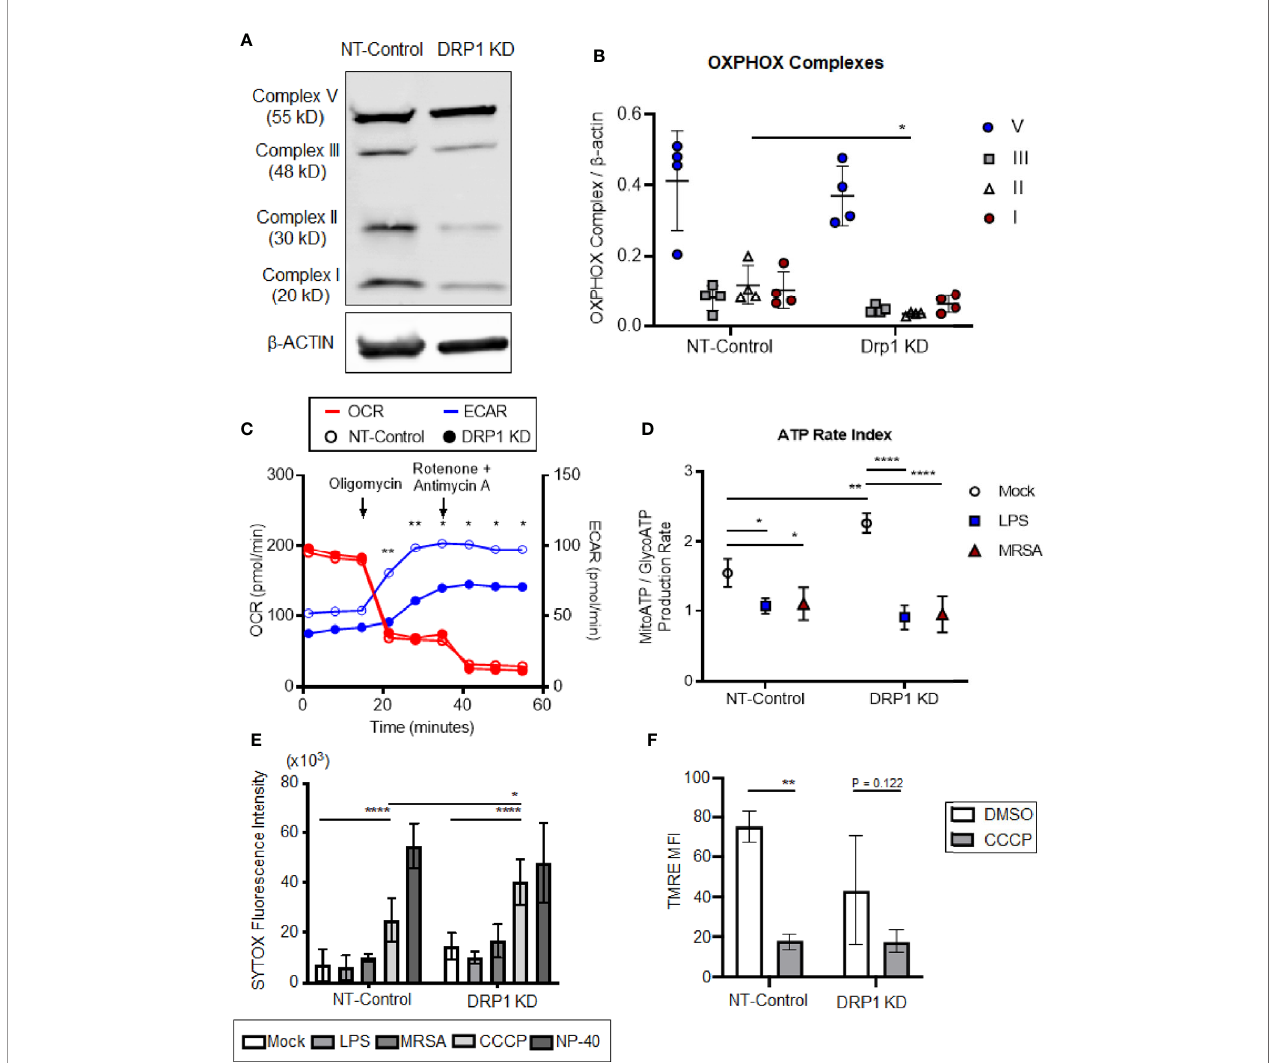
FIGURE 2 | Silencing macrophage DRP1 does not in fl uence metabolic reprogramming and cell death during immune stimulation. (A) Representative immunoblot of OXPHOX mitochondrial complexes protein expression from NT-Control and DRP1 KD macrophages. (B) Quanti fi cation of immunoblots from (A) . Graph symbols represent the ratio of OXPHOX Complex I-V expression levels relative to b -ACTIN of four independent experiments with mean ± SD. (C) Overlaid measurements of extracellular acidi fi cation and oxygen consumption rates (ECAR and OCR, respectively) using Agilent Seahorse ATP real-time rate assay in NT-Control and DRP1 KD macrophages. (D) Quanti fi cation of ATP rate index (a metabolic shift from mitochondrial respiration to glycolysis) in NT-Control and DRP1 KD macrophages when cells were left untreated (Mock), stimulated with LPS for 4h (LPS) or infected with MRSA at MOI of 20 for 4h (MRSA). ATP rate index is the ratio of the rate of mitochondrial ATP (MitoATP) production over glycolytic ATP (GlycoATP) production rate, which was quanti fi ed using the Agilent Seahorse ATP real-time rate assay. (E) SYTOX green fl uorescence intensities of NT-Control and DRP1 KD macrophages were measured by plate reader after cells were exposed to DMSO, LPS (200 ng/ml), MRSA (MOI 20), CCCP (5 m M) or NP-40 (2%) for 8h. (F) Mitochondrial membrane potential was assessed by fl ow cytometry using TMRE dye. Mean fl uorescence intensity (MFI) of NT-Control and DRP1 KD macrophages after 15min labeling with TMRE when cells were exposed for 4h to DMSO or CCCP (5 m M). MFI quanti fi cation was determined using FlowJo software, representing the geometric mean. Unless otherwise stated, graphs indicate mean ± SD of n ≥ 3 independent experiments. Two-way ANOVA followed by Sidak ’ s multiple comparisons test was performed to determine statistical signi fi cance. * P < 0.05; ** P < 0.01; **** P < macrophages even though CCCP treatment disrupted lower levels of reduced resazurin and WST-1 compared to NT- mitochondrial membrane potential similarly in both cell lines Control cells, but stimulation with LPS did not lead to changes in ( Figure 2F ). These results support a pro-survival role for DRP1 when mitochondrial membrane potential is compromised, likely ( Figure S3 ). However, we found that DRP1 blocked CCCP- through clearance of damaged mitochondria by mitophagy (Twig et al., 2008). uorescence intensity in DRP1 KD relative to NT-Control